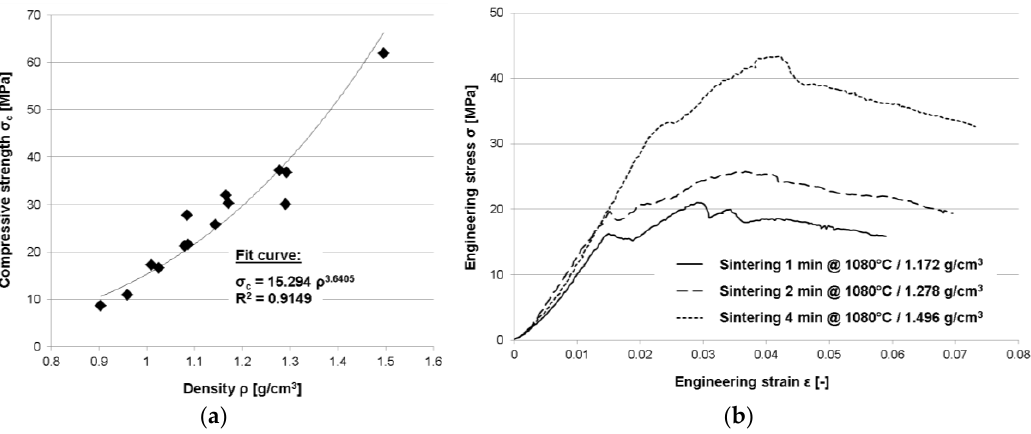
Figure 3. Mechanical performance of Cu@CS materials: ( a ) Compressive strength data plotted vs. (geometry-based, see Table 1) density values; ( b ) Examples of typical engineering stress–strain curves for different density levels, underlining the limited failure strain observed.